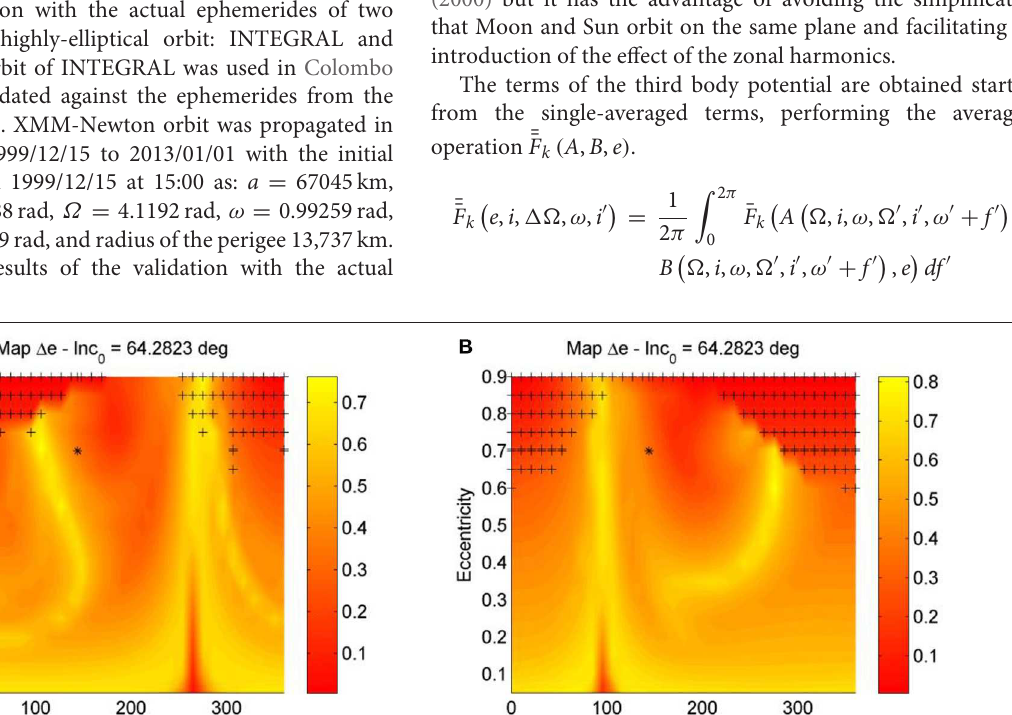
Frontiers in Astronomy and Space Sciences |